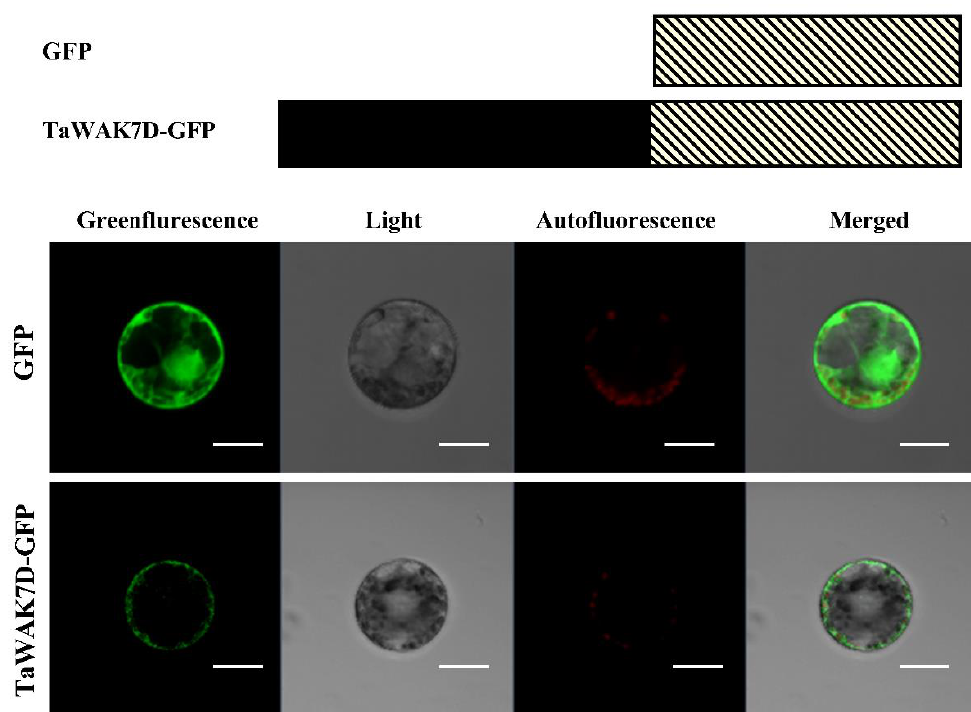
Figure 3. Subcellular localization of TaWAK7D in wheat protoplasts cells. The control GFP and fused TaWAK7D–GFP are transiently expressed in mesophyll protoplasts cells. The red colour was auto-fluorescence from wheat chloroplast. Scale bars = 2 0 μm (wheat protoplasts).